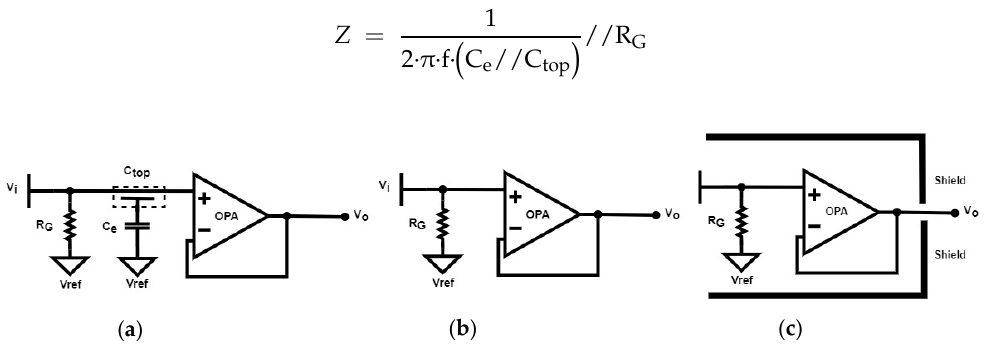
Figure 3. Three CECG electrodes. ( a ) The proposed electrode, ( b ) a high input impedance electrode and ( c ) the one in ( b ) is enclosed with a guard ring for noise